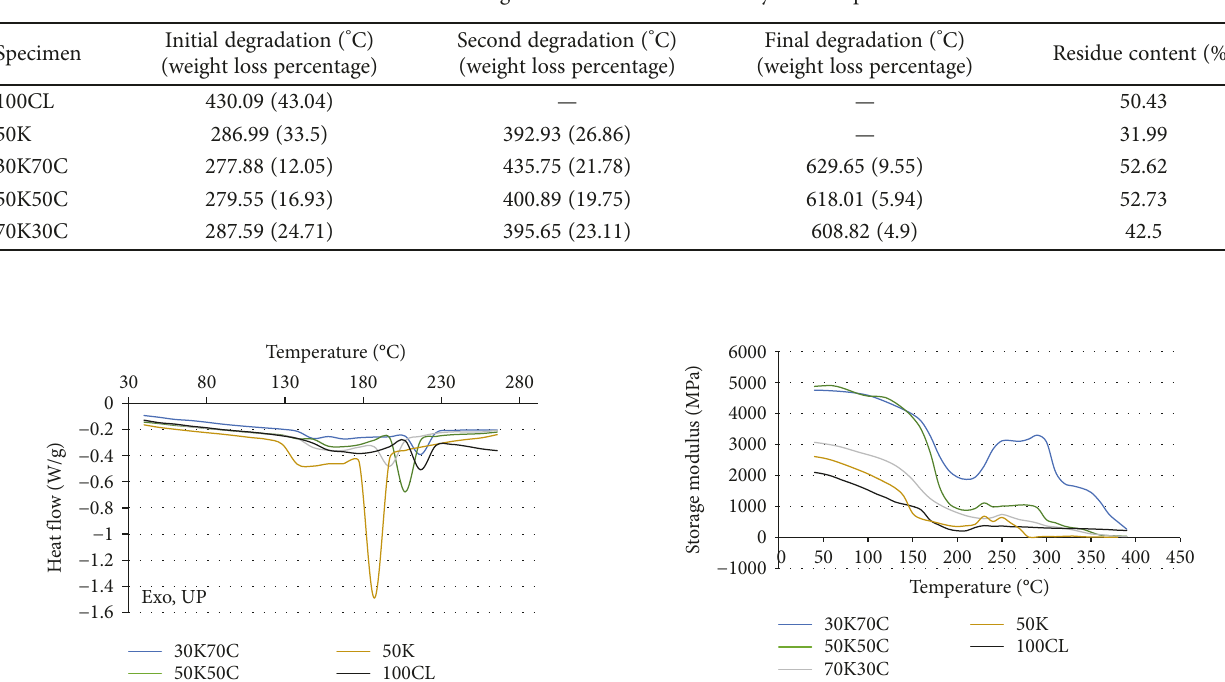
Table 2: Thermal degradation characteristics of hybrid composites.